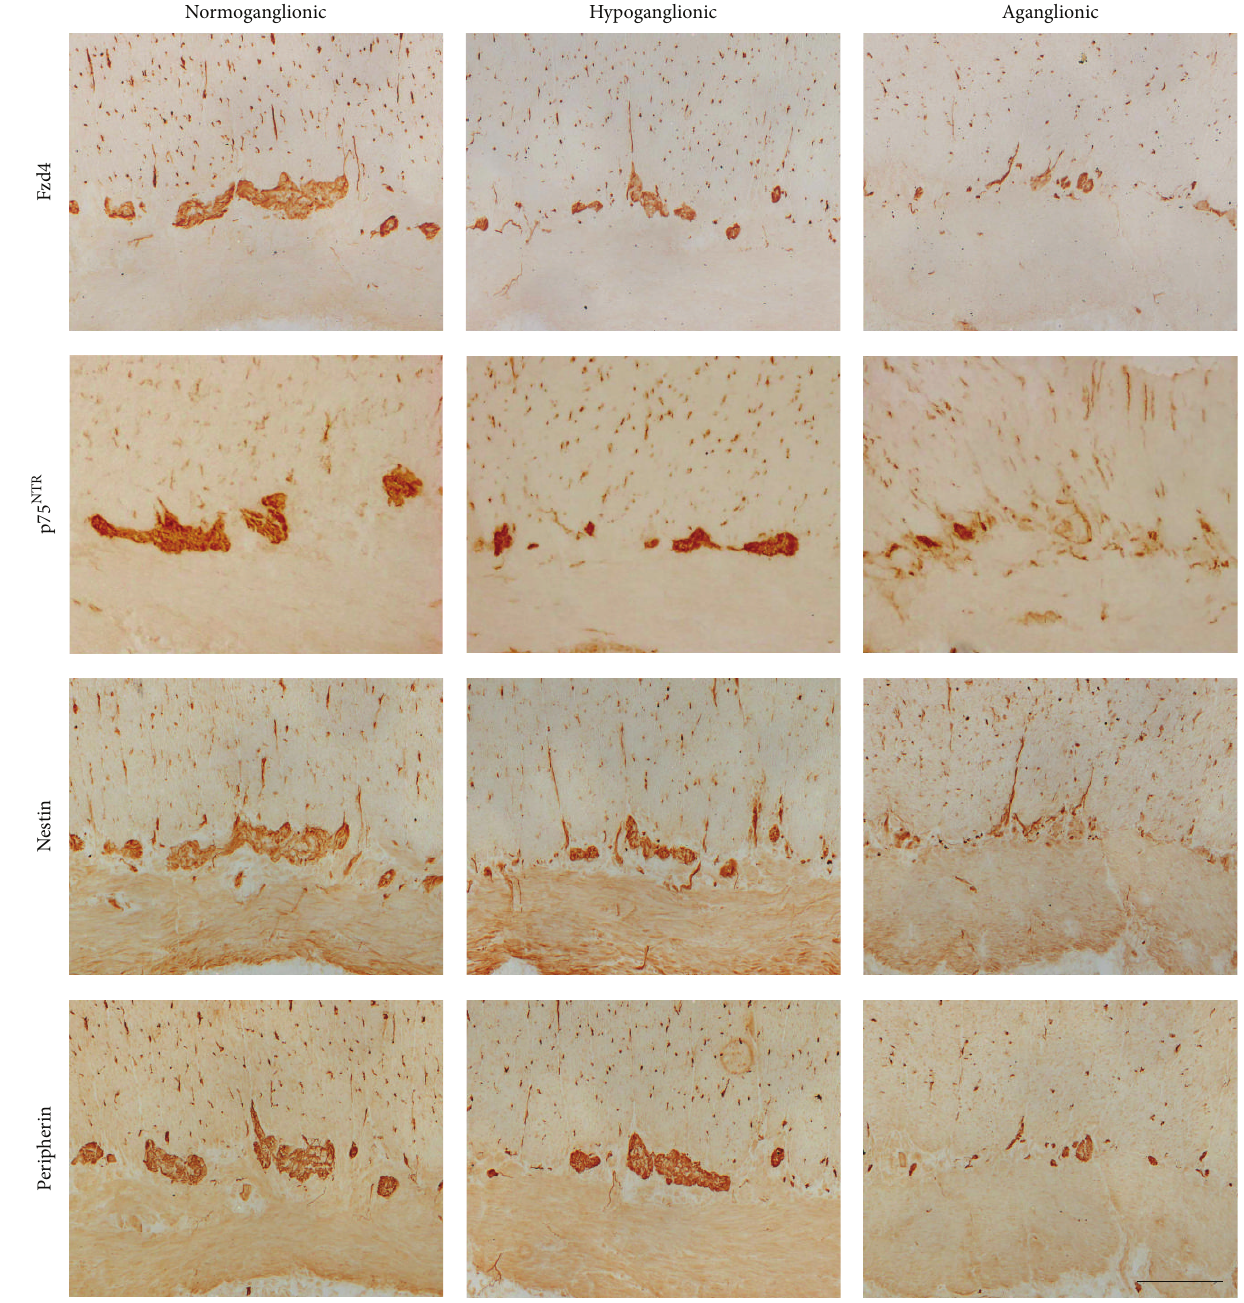
Figure7:Theexpressionoffrizzled-4inHirschsprung’sdiseasedecreasesfrombeingoraltoanal.Immunohistochemicalanalysisforfrizzled- 4 (Fzd4) in comparison to p 75 NTR , nestin, and peripherin on cryostat sections from large intestine diagnosed with Hirschsprung’s disease (sample number 10). Microscopic brightfield views were taken from normoganglionic, hypoganglionic, and aganglionic areas, respectively; scale bar: 200 𝜇